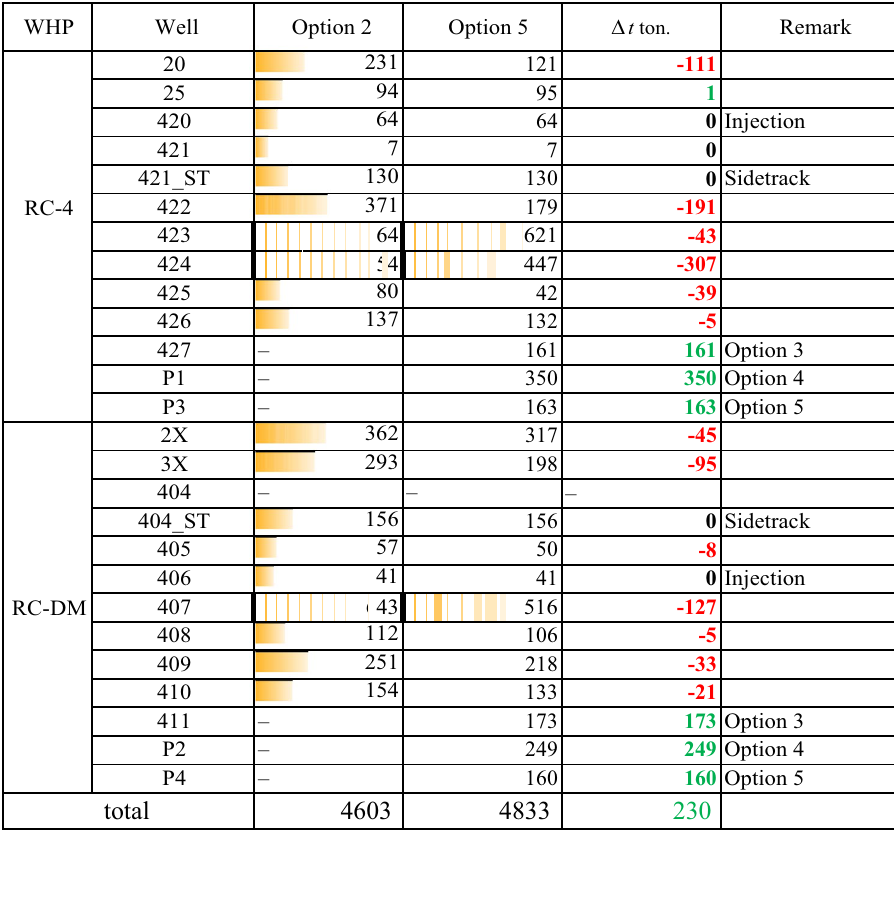
Fig. 14 Comparison of dynam‑ ics of well stock change and oil production in the cases 2 and